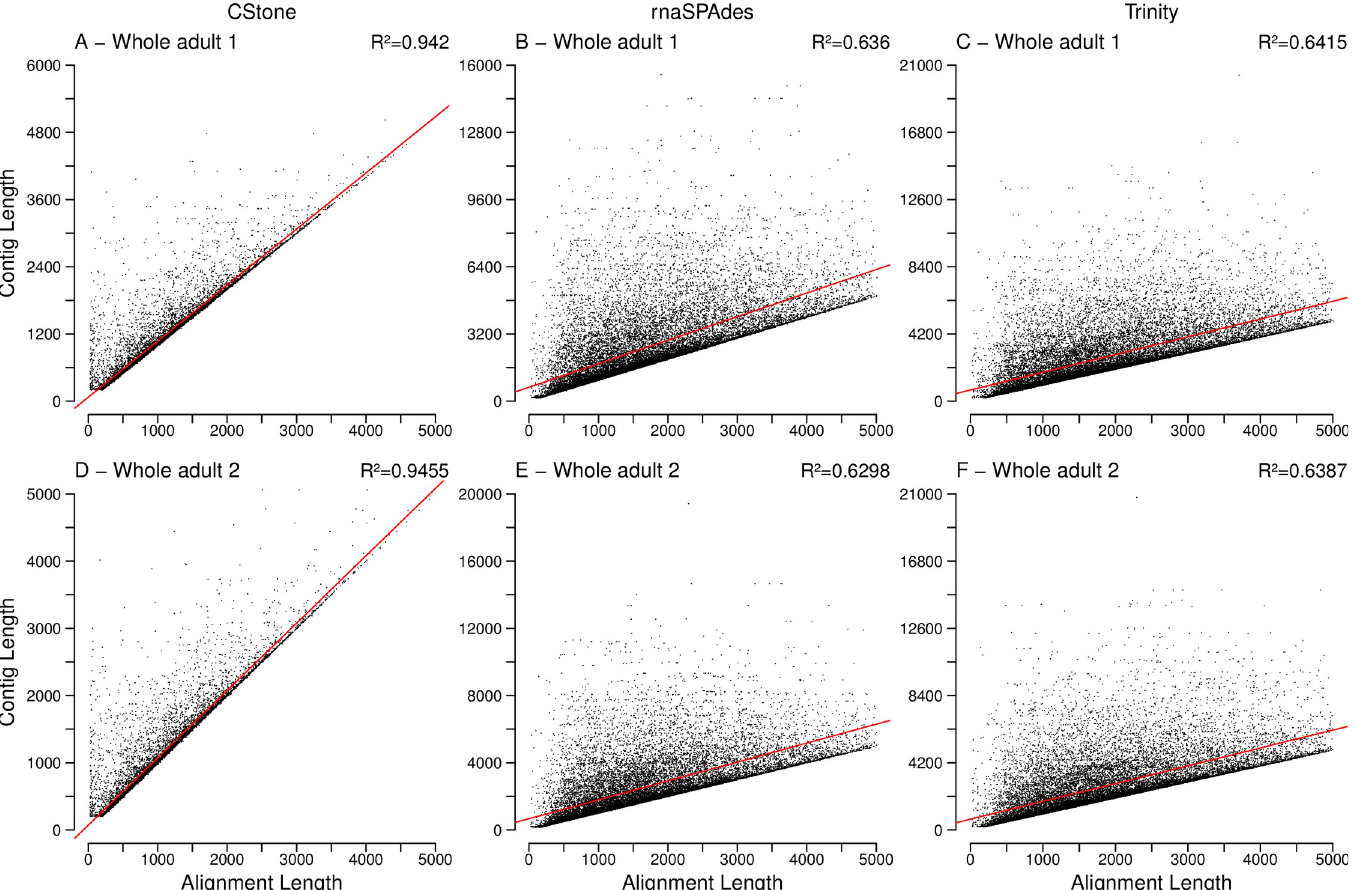
Fig 11. Length of aligned region versus length of contig. R 2 values, located on the top right corners, indicate the correlation between contig lengths and aligned region lengths. The description of the rest of the figure is identical to that of Fig 5.